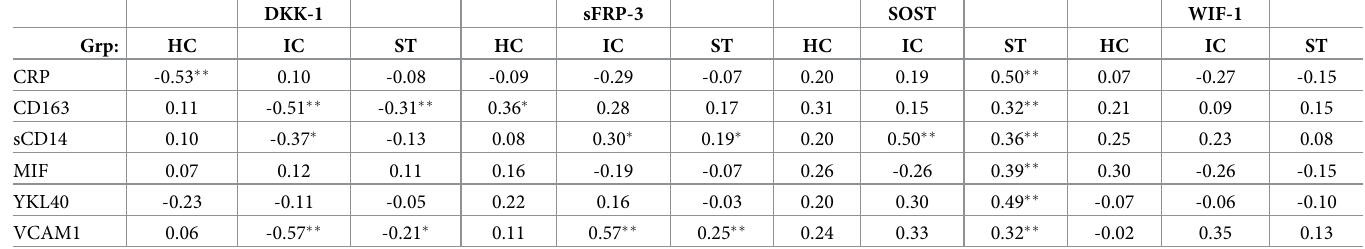
Table 2. Plasma levels of secreted Wnt antagonists in relation to markers of inflammation, immune and endothelial cell activation in healthy controls (HC), infec- tious controls (IC) and patients with scrub typhus (ST). DKK-1 sFRP-3 SOST